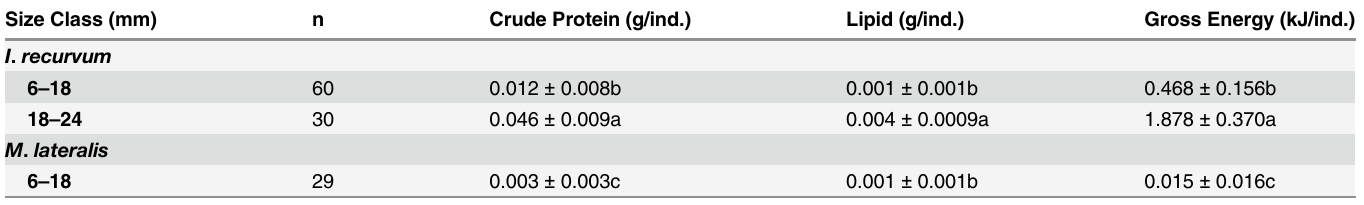
Table 2. The mean amounts ( ± 1 SD) of crude protein (g DM/individual), lipid (g DM/individual), and gross energy (kJ/individual) found for Ischa- dium recurvum and Mulinia lateralis , the top two prey items consumed by wintering surf scoters in the Chesapeake Bay. Size Class (mm) n Crude Protein (g/ind.) Lipid (g/ind.) Gross Energy